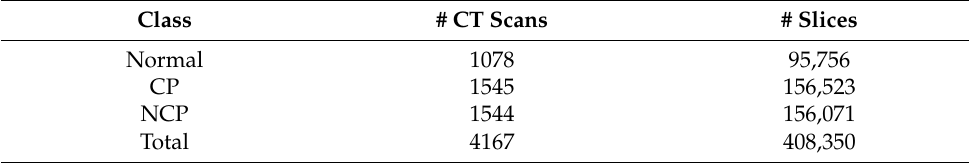
Table 1. CC-CCII dataset. This table reports the number of chest CT scans and slices for patients without lung lesions (i.e., Normal), with common pneumonia (i.e., CP) and with novel coronavirus pneumonia (i.e., NCP). The last row reports the overall size of the dataset. Class # CT Scans # Slices Normal